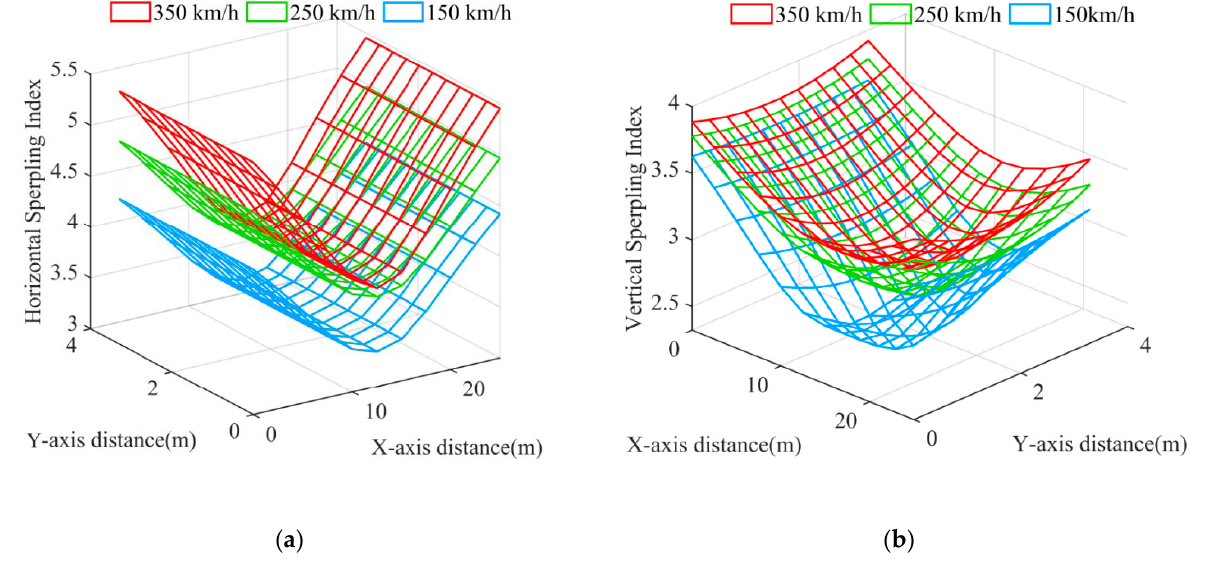
Figure 8. Zonal distribution of car-body Sperling index influenced by the train speed according to PEM: ( a ) horizontal Sperling index; ( b ) vertical Sperling index. PEM: ( a ) horizontal Sperling index; ( b ) vertical Sperling